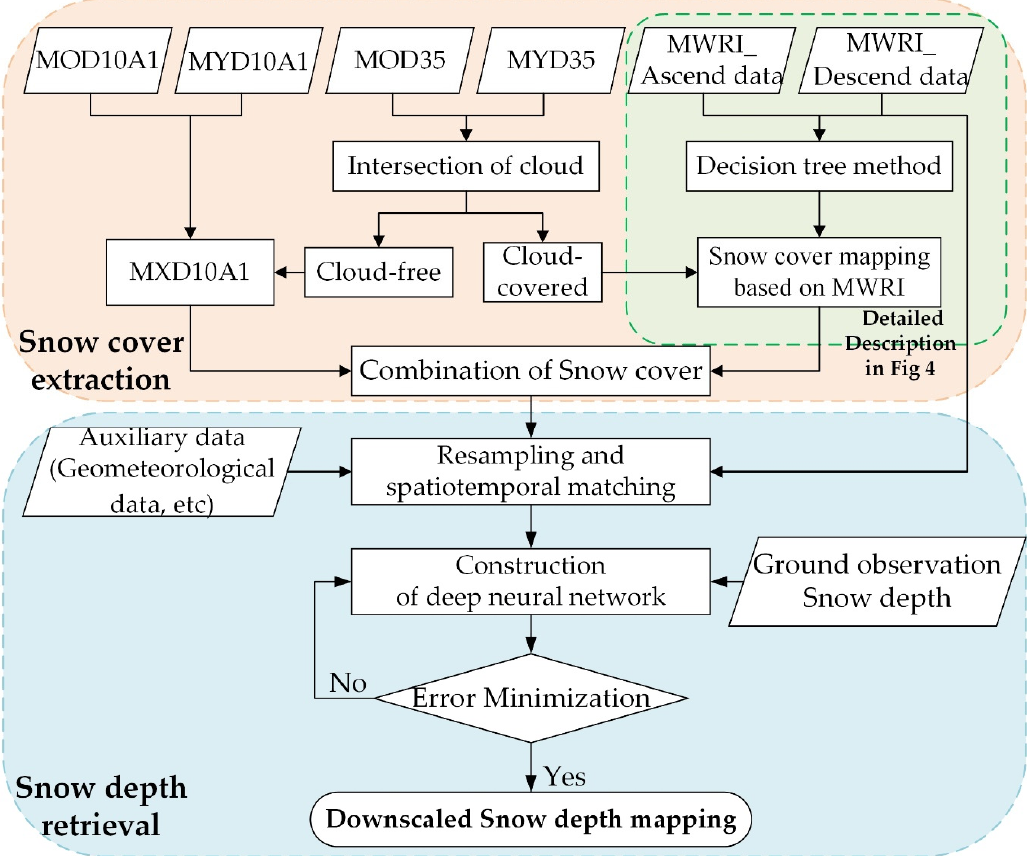
Figure 3. Flow chart of downscaling snow depth